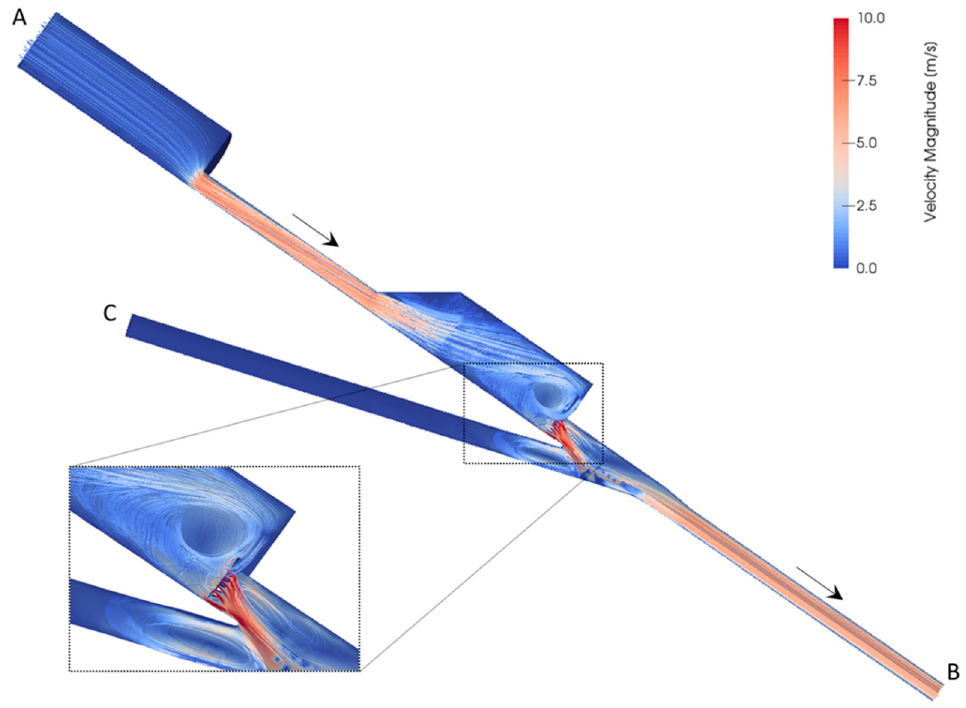
Figure 3. Velocity streamlines for a 14 m 3 /s flow going from A to B (turbine opening) .